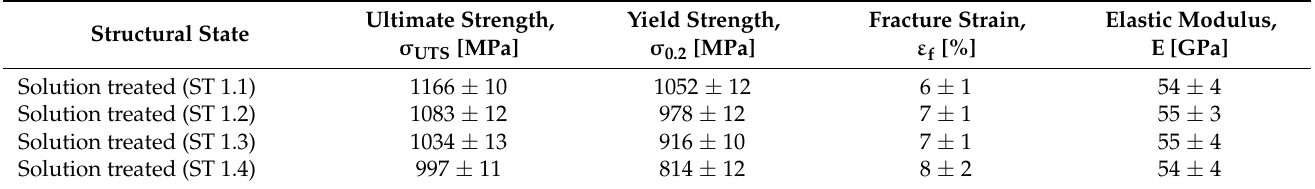
Table 5. Mechanical characteristics of TNTZ alloy solution treated at 800 ◦ C with holding times of: